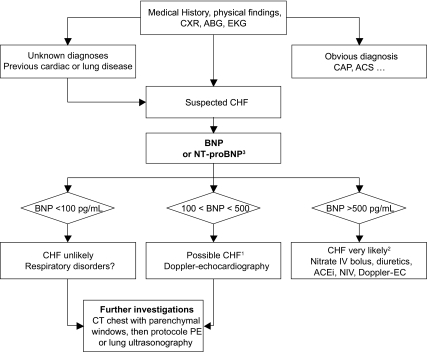
Diagnostic strategy based on B natriuretic peptide levels in elderly patients admitted for ARF in the emergency department.1In the grey zone (BNP between 100 and 500 pg/mL) which represents less than a quarter of patients, further investigations are needed, and ER physicians should consider massive PE, severe exacerbation of COPD or severe pneumonia as possible diagnoses…2Emergency physicians should be keep in mind that half of elderly patients with ARF has more than one, i.e. a BNP greater than 500 pg/ml strongly suggests CHF, but other diagnosis could have precipitated CHF.3For NT-proBNP, the cut-off values are 500 and 2,000 pg/mL.Abbreviation: CXR: chest x- ray; EKG: Electrocardiogram; ABG: arterial blood gas analysis; CHF: congestive heart failure; ACS: acute coronary syndrome, CT: computed tomography; IV: intra-venous; NIV: non invasive ventilation including continuous positive airway pressure; ACEi: angiotensin converting enzyme inhibitor; EC: echocardiography.